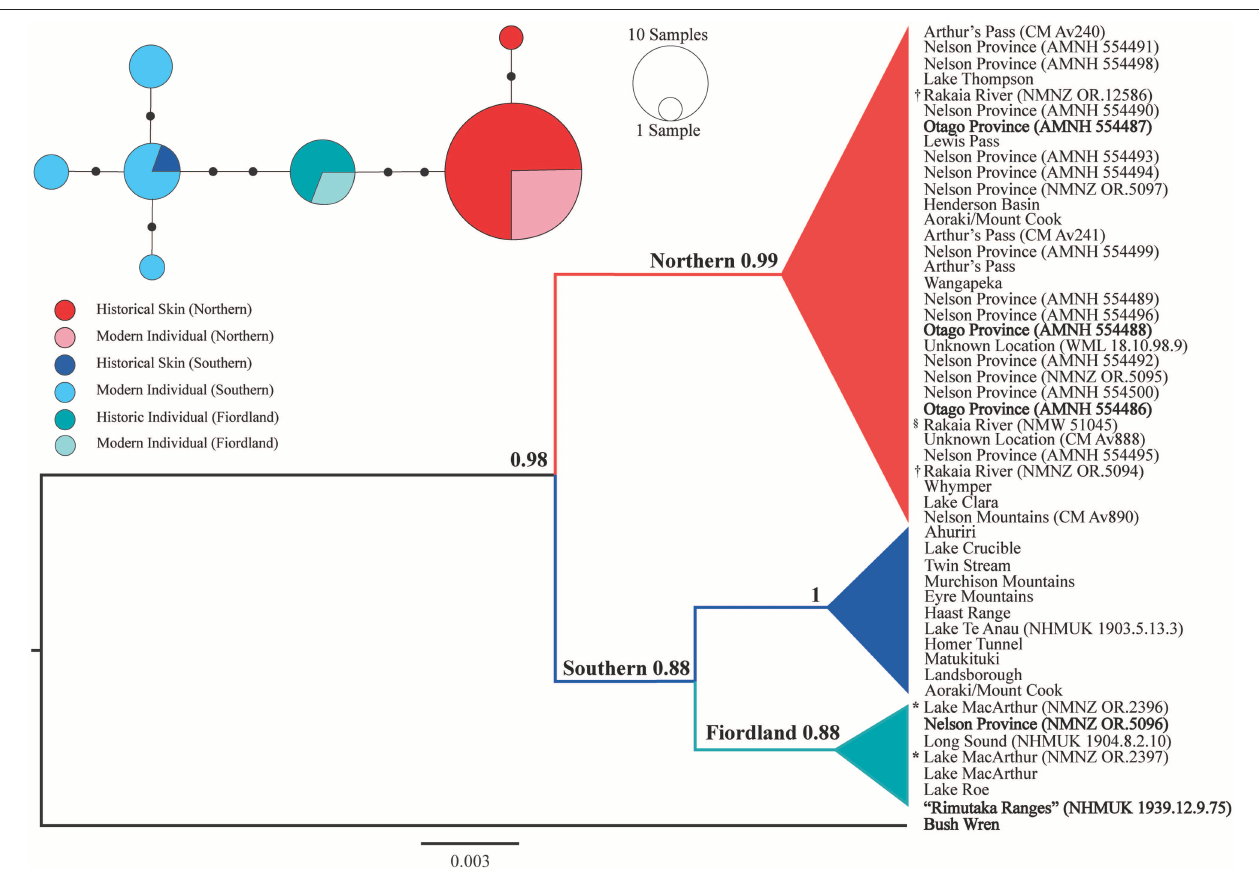
FIGURE 2 | Collapsed Bayesian phylogeny and median-joining haplotype network of NZ rock wren ( Xenicus gilviventris ) mitochondrial cytochrome b sequences (163 bp). Major clades mentioned within the text are identified and posterior probabilities are displayed next to main nodes. Bold labels denote museum specimens for which the recorded collection locality and genetic sequence do not match. * X. gilviventris rineyi type series specimen, † X. haasti syntype, § X. gilviventris syntype. The scale bar depicts the distance corresponding to 0.003 nucleotide substitutions per site. Within the haplotype network, mutational steps are illustrated via small black circles, and haplotypes are colored according to genetic lineage and specimen type (contemporary individual or museum